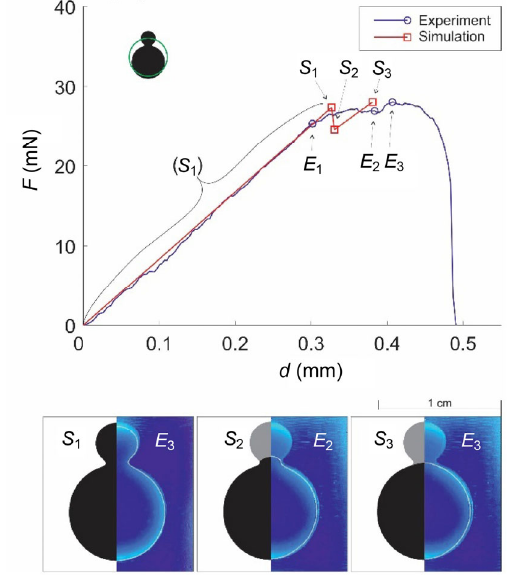
Fig. 14 Dependency of the attracting force on the pull-off distance for a star shape. The blue curve represents experimental data, while the red curve is obtained by simulation. The simulation results were fitted to the experimental data by assuming * 7.60 kPa  E and 1 0.060 N m .     Highlighted points ( S 1 , S 2 , E 1 , E 2 , E 3 ) refer 12 to the lower part where real contact area for selected pull-off-states are shown. For the third photograph of the experiment, no equivalent stable solution in the numerical simulation was reached.